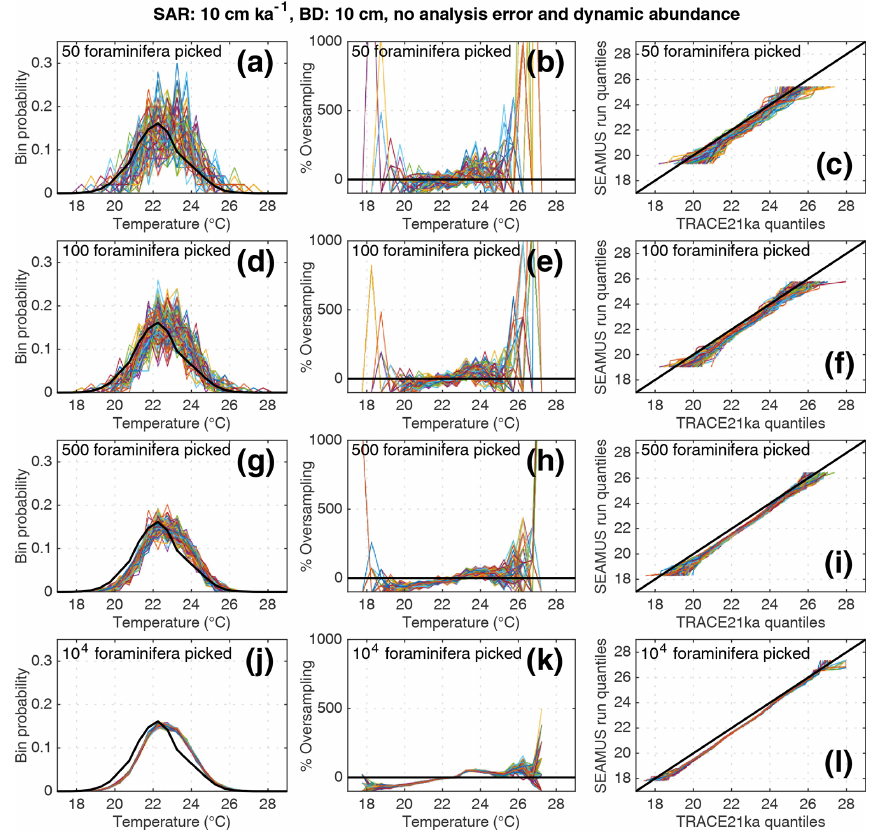
Figure 7. Simulated single foraminifera SST distributions from 100 ensembles of SEAMUS runs, with SAR of 10cmkyr − 1 , BD of 10cm, no analytical error and dynamic abundance (following Fig. 2a). In each ensemble, the single foraminifera SST distribution from a single discrete depth with a simulated median age of 17.5ka is compared to the TRACE-21ka SST distribution for the 18 to 17ka period. The left panels (a, d, g, j) show the 100 SEAMUS ensembles as coloured lines in the case of 50, 100, 500 and 10 4 randomly picked foraminifera, with the TRACE-21ka SST distribution shown as a black line. The middle panels (b, e, h, k) show the rate of oversampling/undersampling for each of the 100 SEAMUS ensembles (coloured lines) relative to the TRACE-21ka SST distribution (black line) in the case of 50, 100, 500 and 10 4 randomly picked foraminifera. The right panels (c, f, i, l) show Q–Q plots of the 100 SEAMUS ensemble quantiles vs. the TRACE- 21ka quantiles as coloured lines in the case of 50, 100, 500 and 10 4 randomly picked foraminifera, with a perfect 1:1 correspondence to TRACE-21ka shown for reference as a black